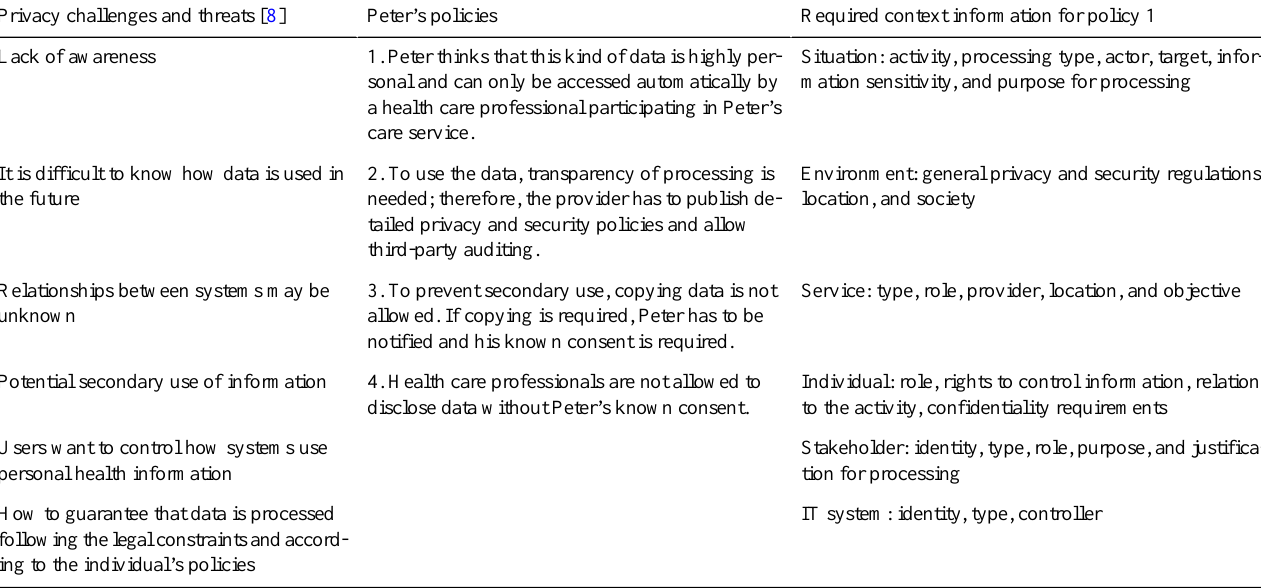
Table 2. An example analysis of an activity: data is created in the sensors and transferred to the